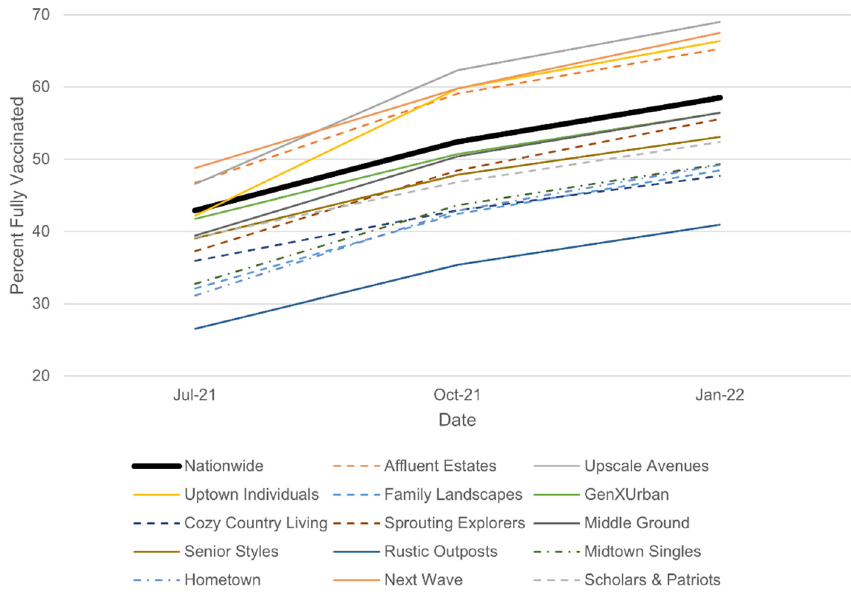
Figure 2. Mean vaccination rates for each of the fourteen LifeModes vs. the nationwide mean plotted over time.